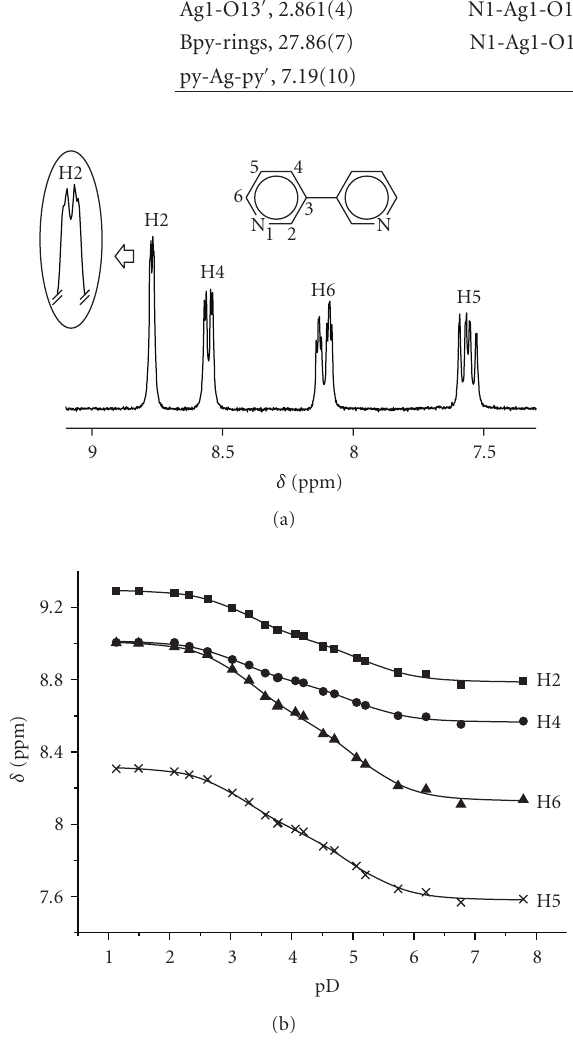
Figure 2: (a) Low field section of 1 H NMR spectrum of 3,3 (cid:2) -bpy (D 2 O, pD = 6.8) and pD dependence of individual resonances, focusing splitting of the H2 resonances. (b) pD dependence of H2, H4, H6, and H8 resonances of free 3,3 (cid:2) -bipyridine.